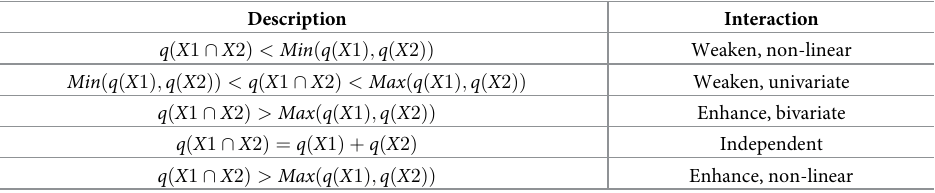
Table 1. Description of interactive